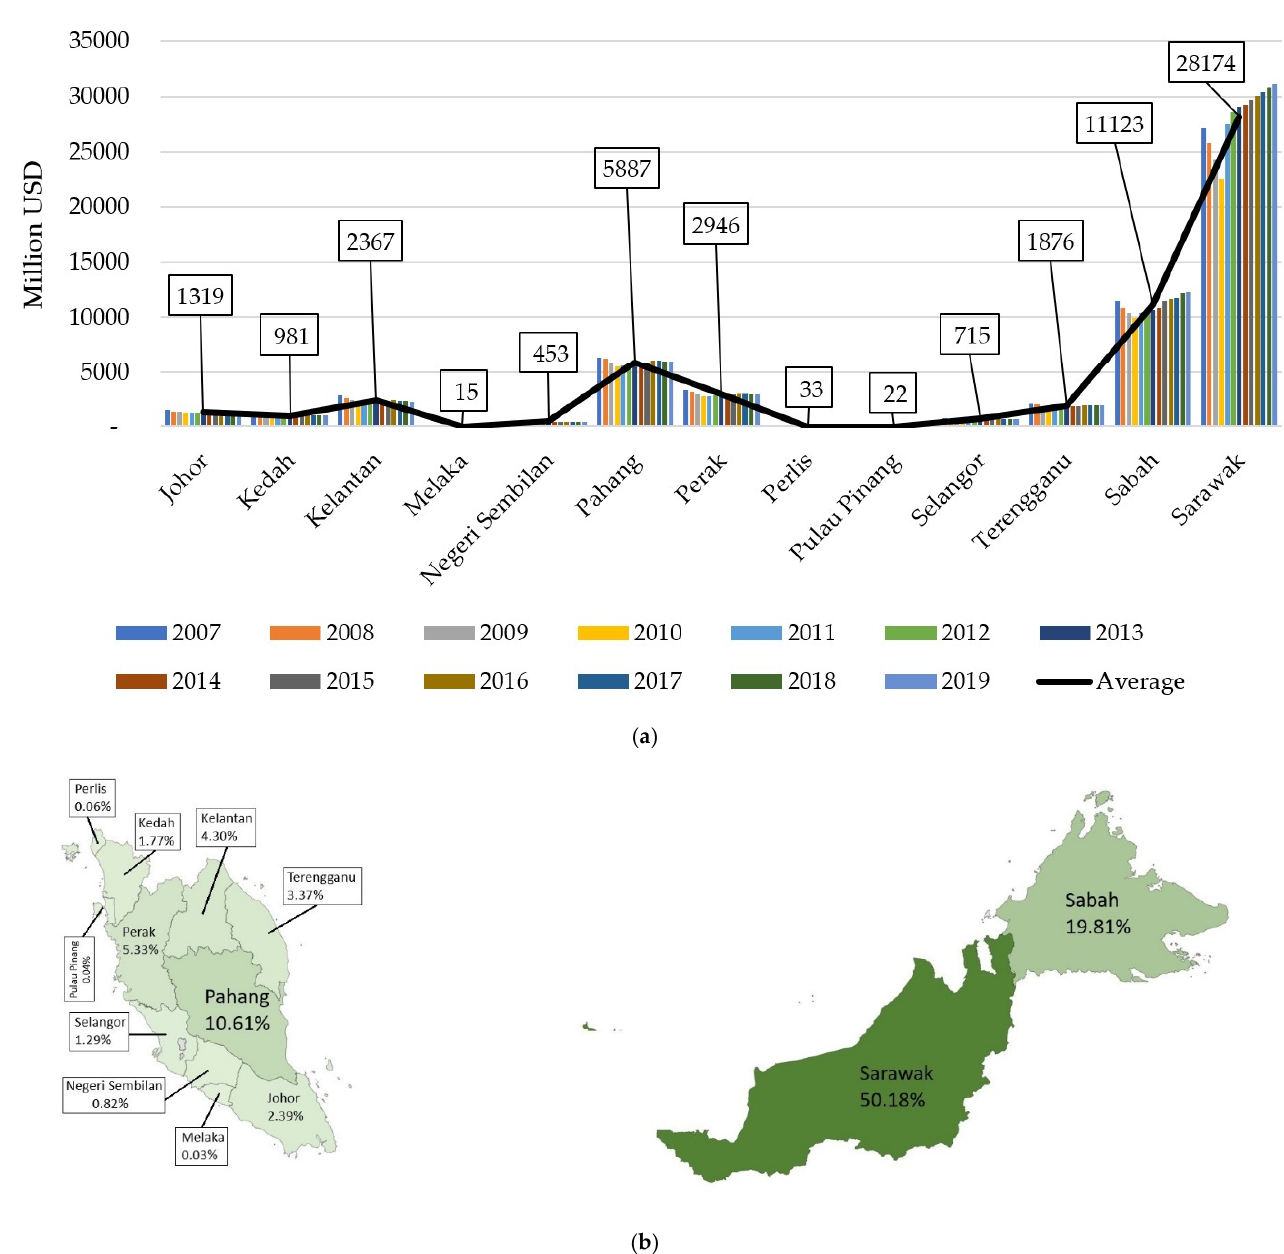
Figure 8. Contribution to the total forest carbon stock among the states in Malaysia. ( a ) Economic value of forest biomass carbon stock from 2007 to 2019 among the Malaysian states; ( b ) Average percentage of contribution to the total forest biomass carbon stock among the Malaysian states.